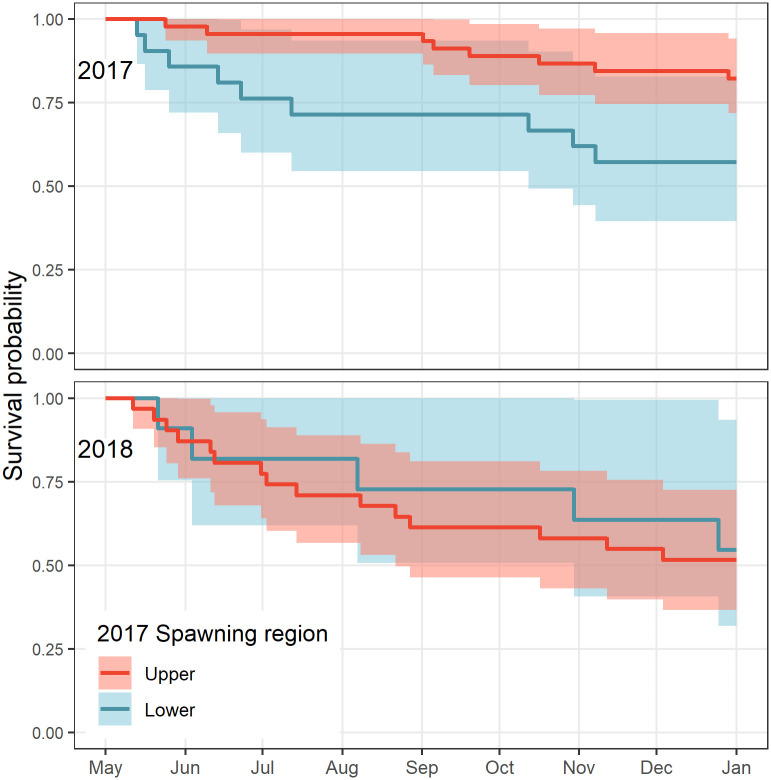
Kaplan-Meier curves of post-run fish by 2017 spawning run contingents classification in 2017 and 2018.Lines are coded red for the classified upper reach and blue for the lower reach contingents. 95% confidence intervals are shown as envelopes.